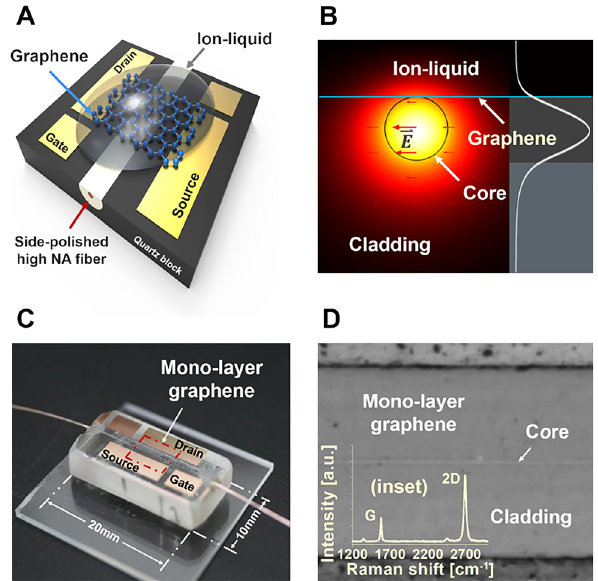
Figure 1: (A) Schematic description of the all-fiber graphene device, (B) cross-sectional view of the calculated mode field distribution of the device, (C) photographic image of the fabricated device without ion liquid, and (D) optical microscope image of the side-polished section of the device (Inset: measured Raman spectrum of monolayer quartz block with a curvature of 0.25 m was laterally pol- ished, and the source, drain, and gate channels were